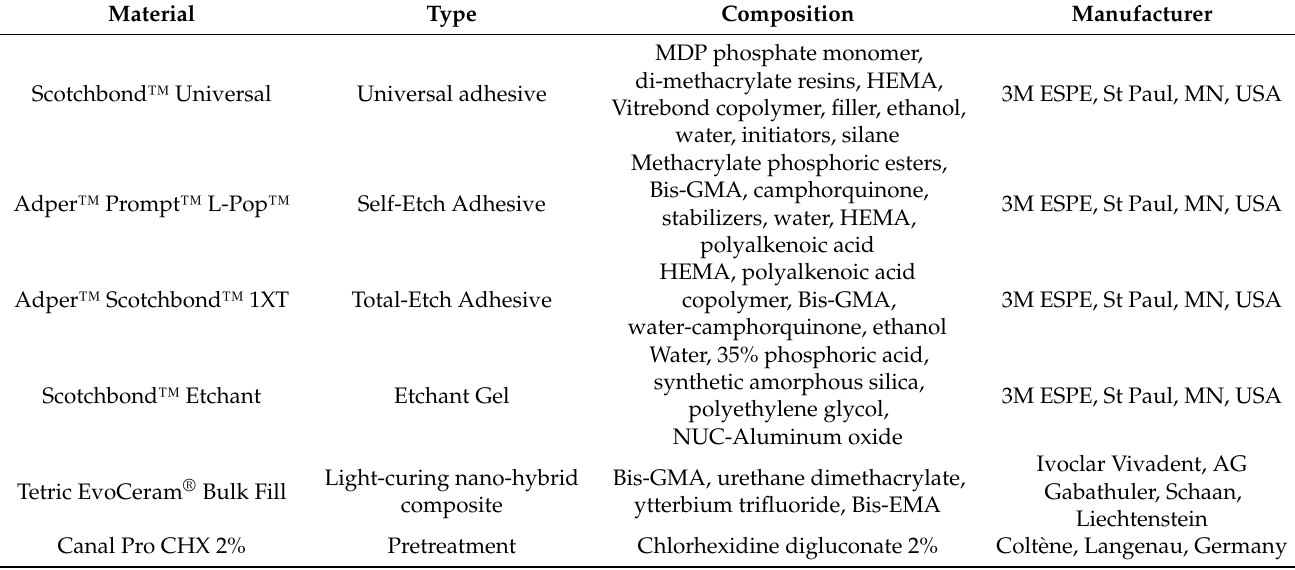
Table 2. Materials used in the